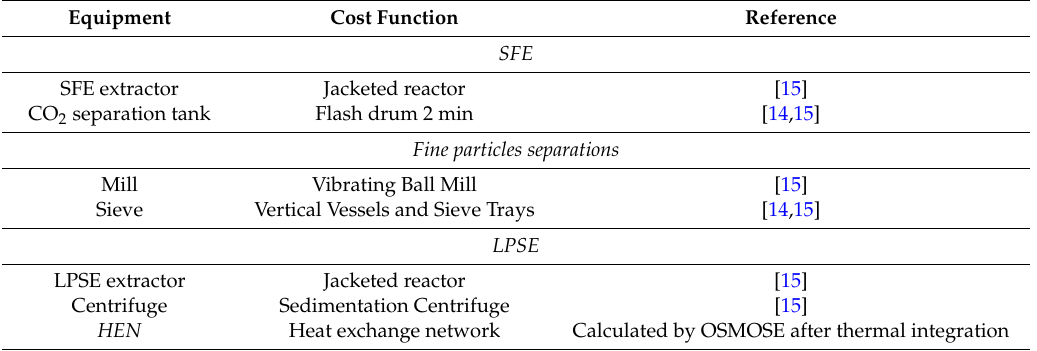
Table B1. Cost function for the evaluated equipment defined in the economic analysis simulated in